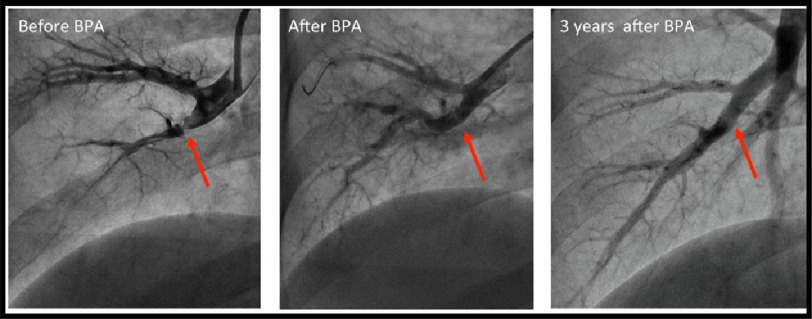
Representative selective pulmonary angiogram after balloon pulmonary angioplasty (BPA).Adapted from Matsubara et al. Balloon pulmonary angioplasty126.